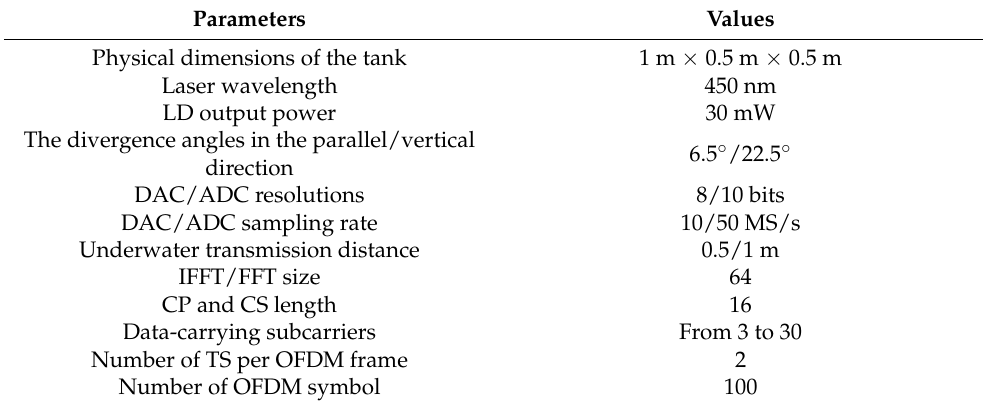
Table 1. Key parameters of the UWOC